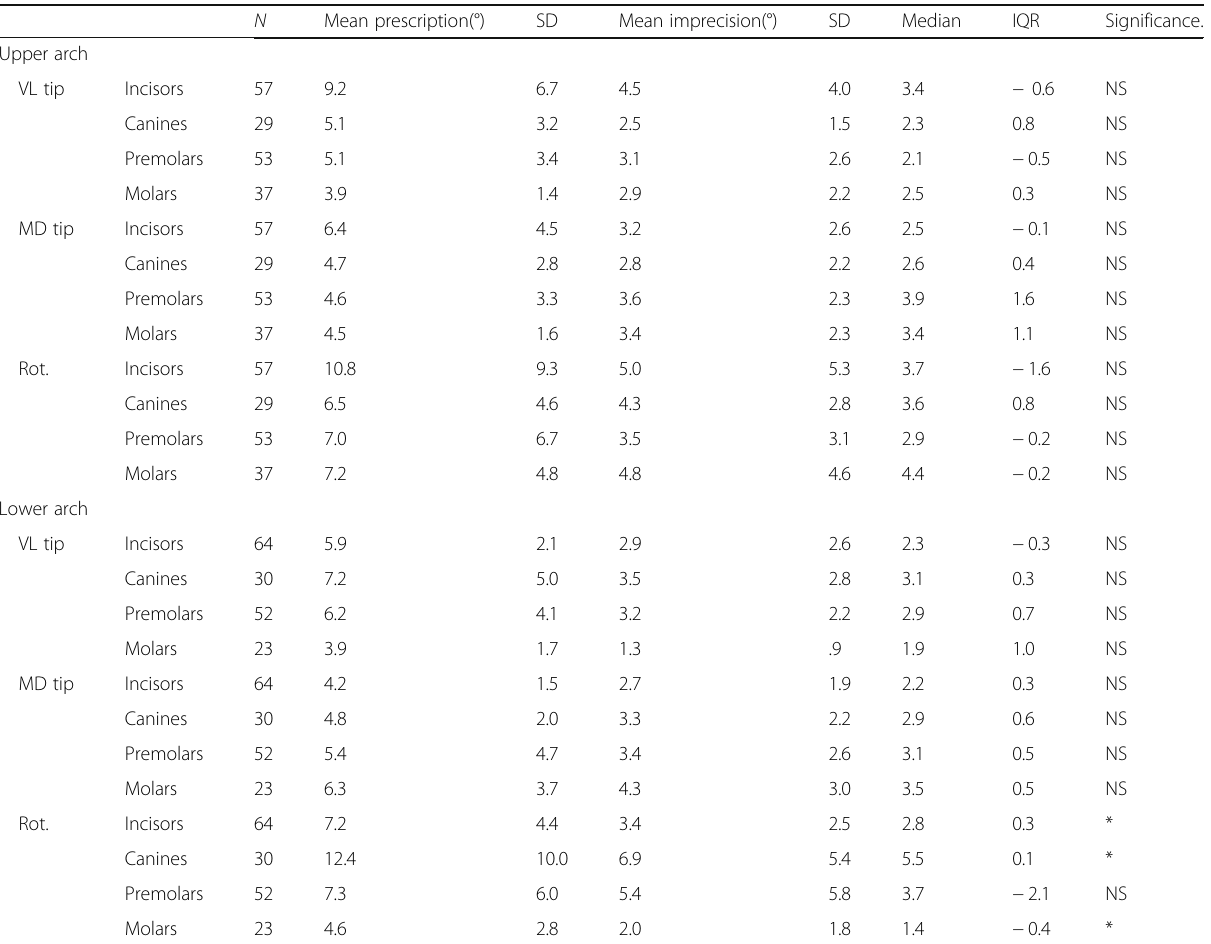
Table 3 Mean prescription and mean imprecision values